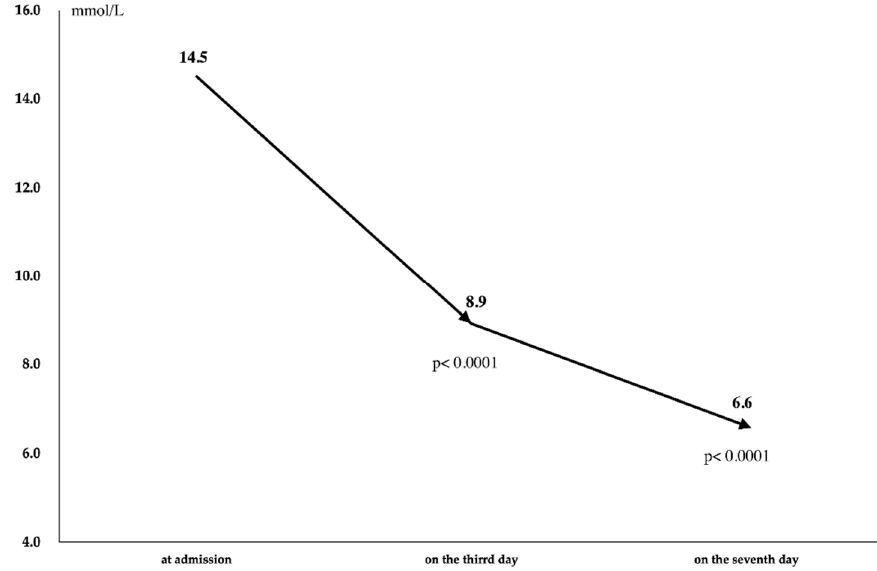
Figure 2. Serial changes of median blood glucose level.